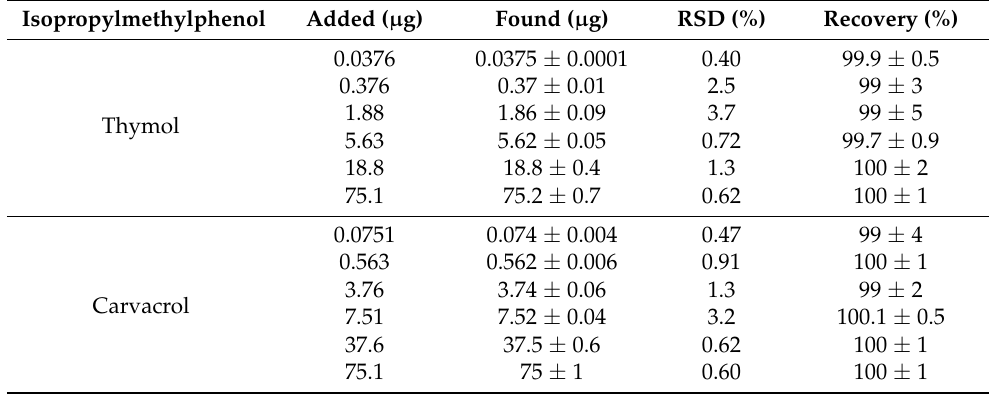
Table 4. Quantification of isopropylmethylphenols in model solutions using polythymolph- thalein/MWCNTs/GCE in Britton–Robinson buffer pH 2.0. ( n = 5; p = 0.95). Isopropylmethylphenol Added ( µ g) Found ( µ g) RSD